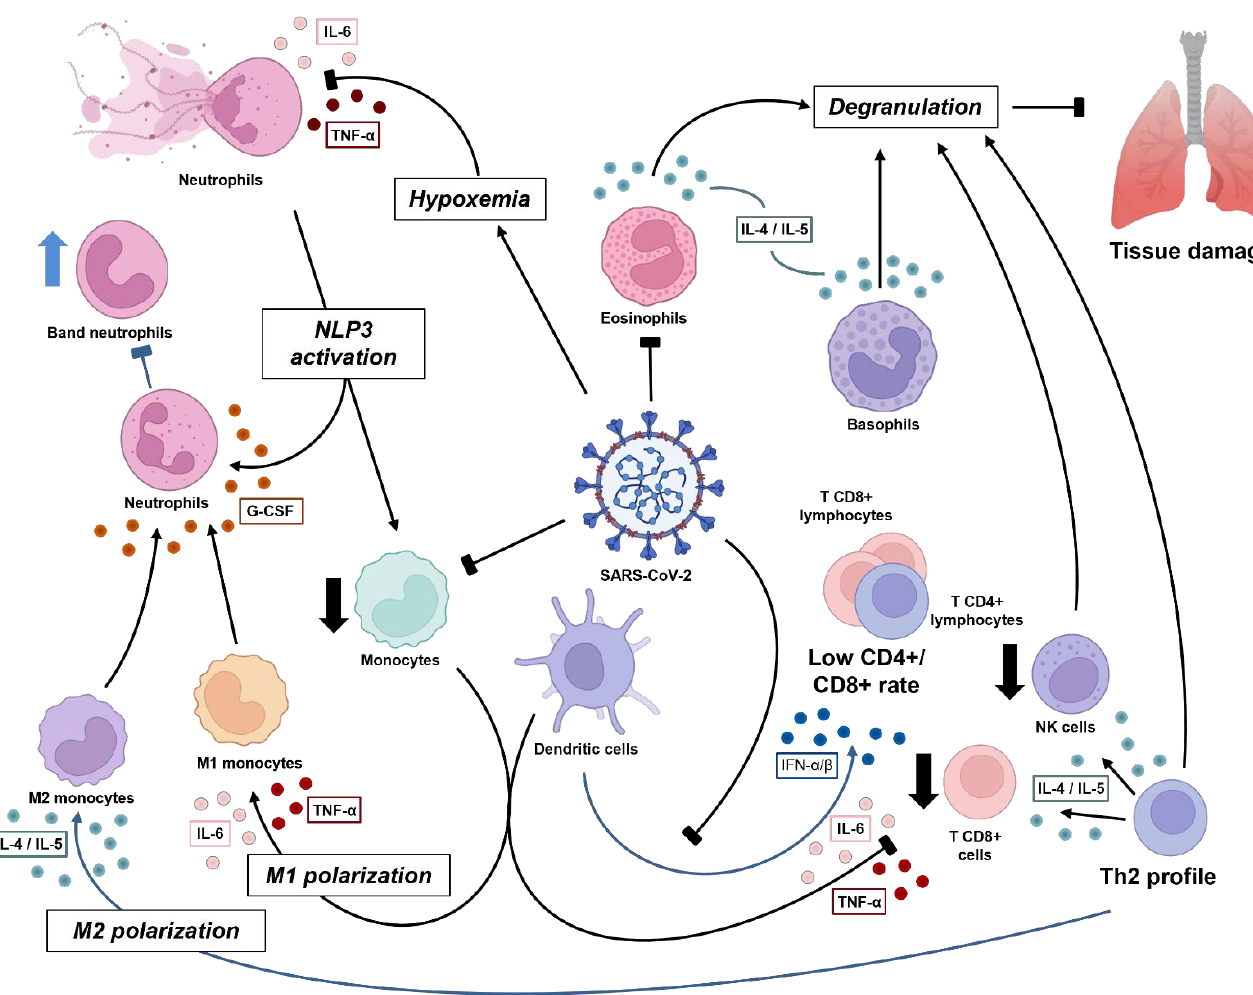
Figure 1. Dynamics of immune cell response against SARS-CoV-2 in acute phase. The virus induces pulmonary damage, which further causes hypoxemia. Both infection and tissue damage lead to inflammatory mediators, mainly interleukin-1 β (IL-1 β ), CXCL8, and IL-6, which further cause NETo- sis and promote positive inflammatory feedback via inflammasome activation in both neutrophils and monocytes. Subsequently, critical patients experience low monocyte count, in terms of both T CD8 + and natural killer (NK) cells, with M1 polarization (driven by cytokine storm), all related to a worse clinical condition. Instead, when the antiviral stage is established, there is sustained type I interferon (IFN) by dendritic cells, contributing to the Th2 profile (IL-4 and IL-5), which induces the degranulation process by lymphocytes (CD8+ and NK), eosinophils, and basophils, and an M2 polarization, which results in a better prognosis. The release of granules has good and bad effects, whereby they can damage viral and human infected cells, but may also damage normal tissue, char- acterizing the respiratory syndrome. Macrophages produce granulocyte colony-stimulating factor (G-CSF), which acts in bone marrow to mature leukocyte progenitors. This may lead to a ‘ shift to the left ’ and improve viral response.